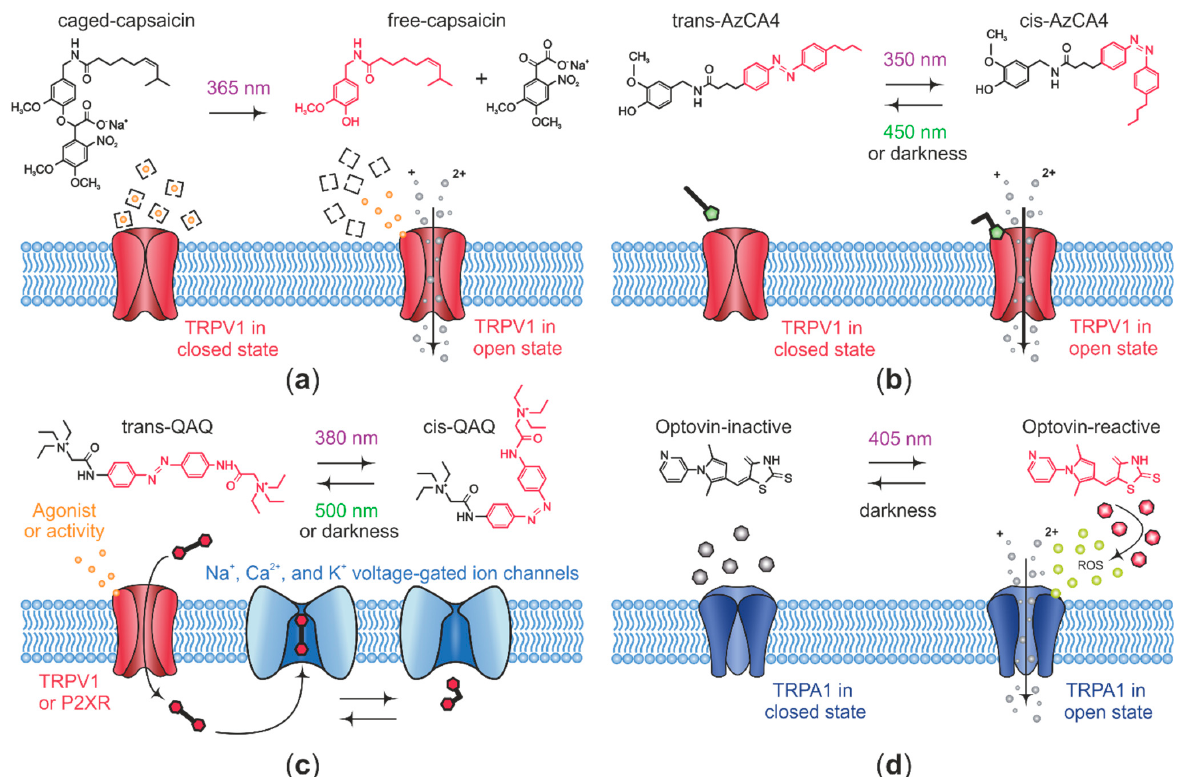
Figure 2. Illustration showing several strategies employed to assess nociceptive transient receptor potential (TRP) channel function using opto-chemicals. ( a ) Caged capsaicin remains inactive until photolysis with 365 nm light releases capsaicin, thus activating the transient receptor potential vanilloid receptor 1 (TRPV1) channels by a non-reversible process. ( b ) AzCA4 (Azo-capsaicin 4) is a photo-isomerizable TRPV1 agonist that activates TRPV1 channels at its cis configuration upon ultraviolet light illumination, whereas it remains inactive after photo-isomerization with blue light or in the dark. ( c ) QAQ (Quaternary ammonium-azobenzene-quaternary ammonium) is a photo-isomerizable compound that permeates open TRPV1 and ATP-gated purinergic receptor 2X (P2XR) channels, and selectively accumulates inside the peripheral nociceptors where it blocks voltage-gated sodium channels (Navs), voltage-gated calcium channels (VGCCs), and voltage- gated potassium channels (Kvs) at its trans- state upon light at 500 nm or in the dark. Conversely, irradiation with 380 nm light turns QAQ to its cis- state, thereby releasing these channels from the blockade. ( d ) Optovin photo-modulates transient receptor potential ankyrin 1 (TRPA1) channel activity by two distinct mechanisms, in which, after illumination with 405 nm light, either activates TRPA1 channels directly by its conversion into a reactive form and subsequent interaction with TRPA1 cysteine residues or indirectly through the generation of singlet oxygen from the surrounding aqueous oxygen. Panel (c) was adapted from Mourot et al., 2013 [117].